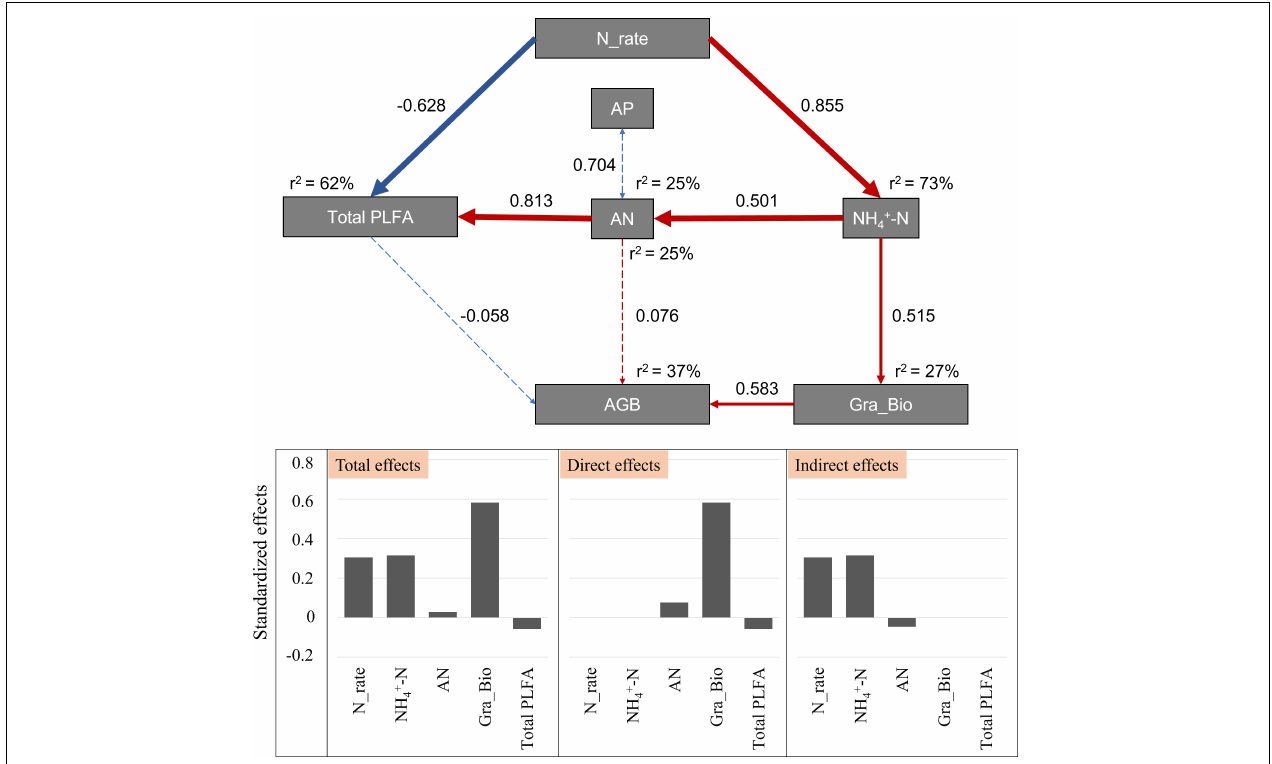
FIGURE 5 | Effects of environmental variables and soil microbes on aboveground biomass after N addition by structural equation model. Blue solid arrows indicate significant positive relationships, and red solid arrows indicate significant negative relationships. Blue dotted arrows indicate negative relationships, and red dotted arrows indicate positive relationships. The thickness of the arrow represents the strength of the relationship. Numbers next to the pathway represent the standardized path coefficients. r2 represents the amount of interpretation. Bar graphs are the standardized effects from SEM on the aboveground biomass. AP indicates the soil available P; AN indicates the soil available N; AGB indicates the total aboveground biomass; Gra_Bio indicates the aboveground biomass of